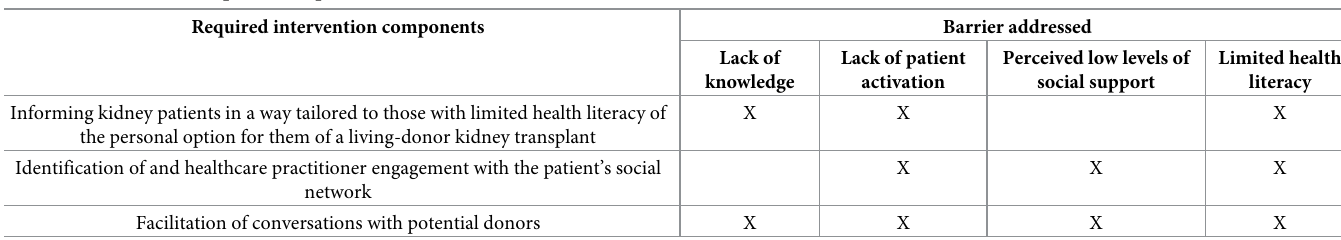
Table 1. Intervention components required to address described barriers. Required intervention